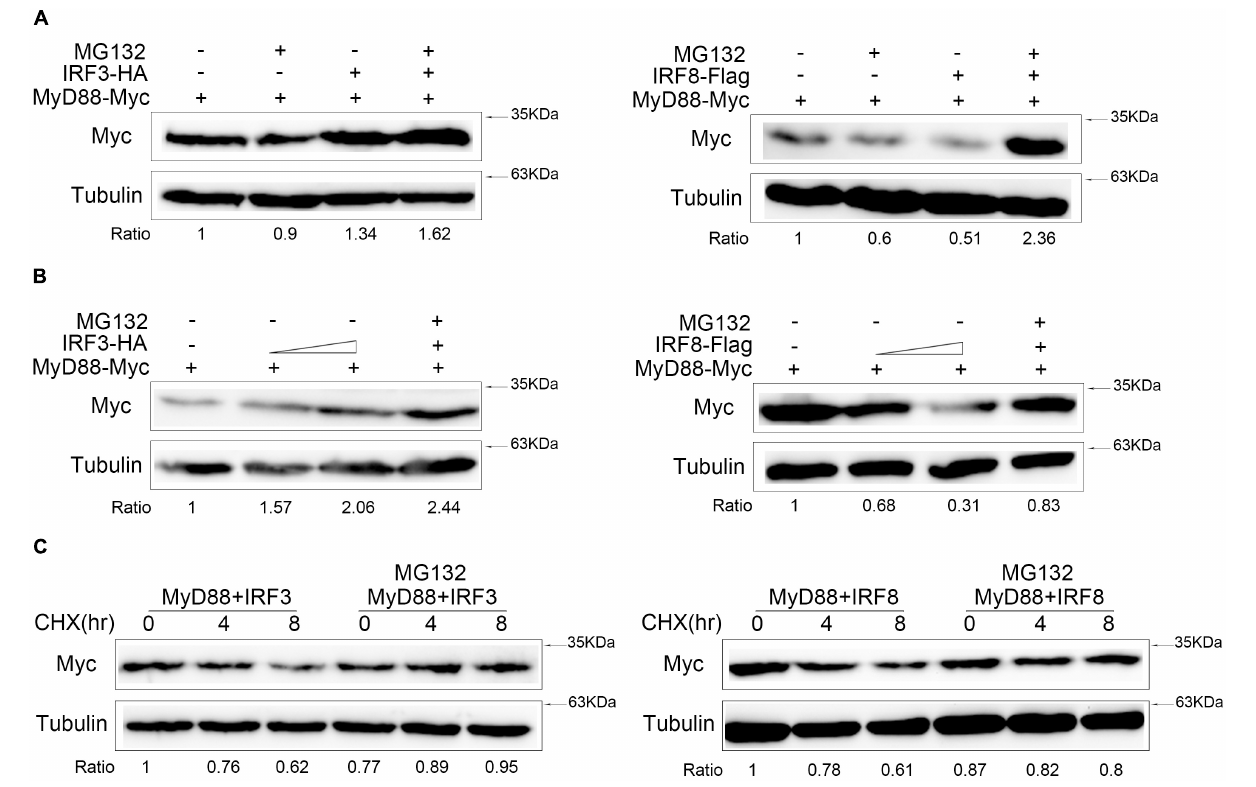
FIGURE 6 | IRF3 and IRF8 regulate MyD88 degradation through ubiquitin–proteasome pathway. (A) HEK293 cells were seeded in 12-well plates and transfected with 0.4 µ g of MyD88 and IRF3 plasmids or IRF8 plasmids for 24 h, and then the cells were treated with dimethyl sulfoxide (DMSO) or 30 µ M of MG132 for 10 h. MyD88 was determined by immunoblot assays. (B) HEK293 cells were transfected with 0.4 µ g of MyD88 and concentration gradient of IRF3 plasmids (0.2 or 0.4 µ g) or concentration gradient of IRF8 plasmids (0.2 or 0.4 µ g). At 24 h post transfection, the cells were treated with DMSO or 30 µ M of MG132 for 12 h, and MyD88 was determined by immunoblot assays. (C) HEK293 cells were transfected with 0.4 µ g of MyD88 and IRF3 plasmids or IRF8 plasmids. After 24-h transfection, the cells were treated with CHX (100 µ g/ml), and the experiment group was treated with 30 µ M of MG132 for different times. MyD88 was determined by immunoblot assays. All experiments were performed in at least three independent